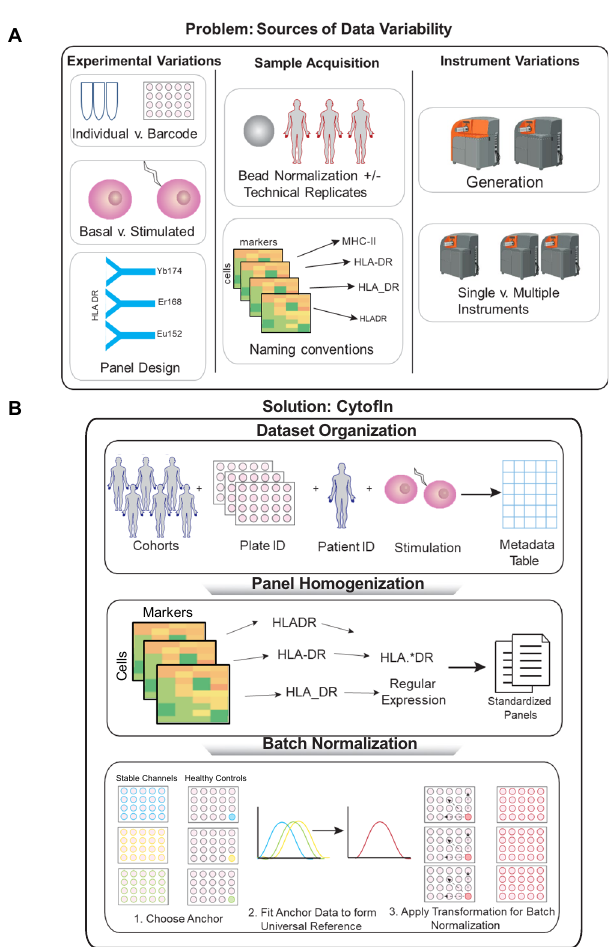
Fig. 1 Overview of CytofIn for mass cytometry data integration. A The challenge of mass cytometry dataset integration from the public domain is limited by sources of data variability during experimental procedures, sample acquisition, and instrument variations, resulting in datasets with heterogeneous fi les and batch effects. B CytofIn, a computational pipeline for integrated analysis of mass cytometry data from the public domain. First, CytofIn organizes mass cytometry data by extracting sample information and experimental conditions and summarizes using a metatable for batch processing. Using regular expression matching, CytofIn homogenizes mass cytometry data fi les by identifying common text patterns found in heterogeneous sets of channel labels. Finally, CytofIn normalizes mass cytometry datasets using generalized anchors, which are non-identical references that exhibit low signal variability across experiments, eliminating the need for beads or identical technical replicates. Figure created with